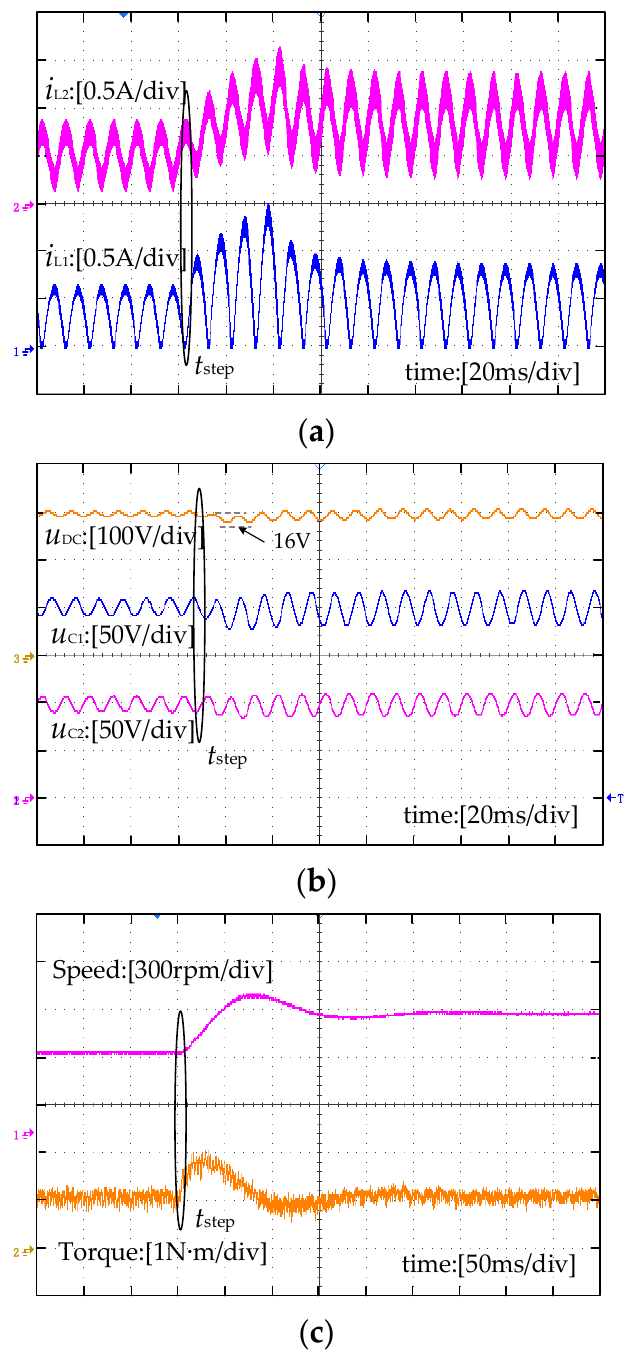
Figure 7. Dynamic experimental waveforms of ECL motor driver under the proposed control strategy with speed-up from 500 to 800 rpm. ( a ) The current of L 1 and the current i L 2 of L 2 . ( b ) DC-link voltage u DC , the voltage of C 1, and the voltage of C 2 . ( c ) Motor speed and motor torque. Figure 8 shows the experimental waveforms of the test ECL driver under the tradi- tional PI control, which has the same experimental conditions as Figure 7. The experimental waveforms show that the grid current obviously lags the motor speed change, which results in the maximum drop voltages of 57 V and 39 V for u C 1 and u C 2 , respectively, and 78 V for the DC-link voltage. Meanwhile, the ECL motor drive system with the traditional control takes 200 ms to restore the drop voltage of the DC-link to the set value and takes 350 ms to reach the given 800 rpm, which is significantly longer than that of the proposed